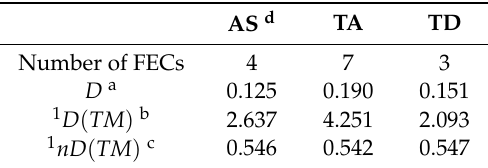
Table 4. Variation among populations in di ff erent locations ( β -diversity) for incidence data, based on FECs of individual plants.